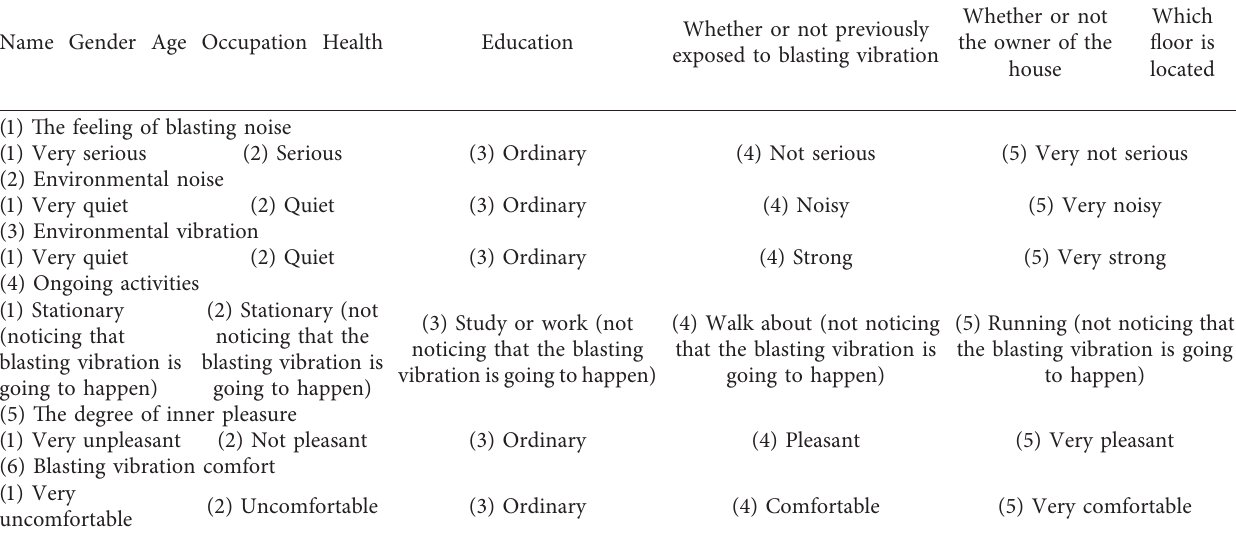
Table 8: Evaluation of blasting vibration comfort.